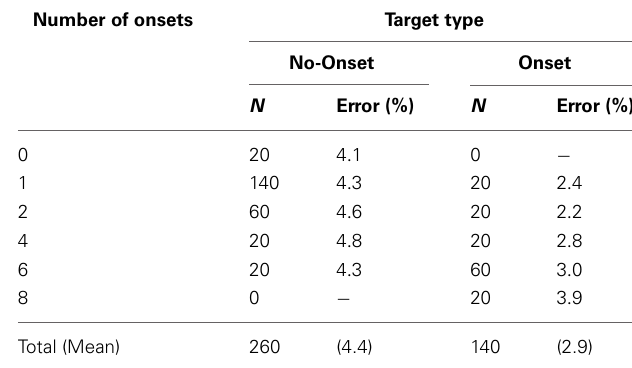
Table 1 | Number of trials ( N ) and percentage errors (%) for different target type and number of onsets in Experiment